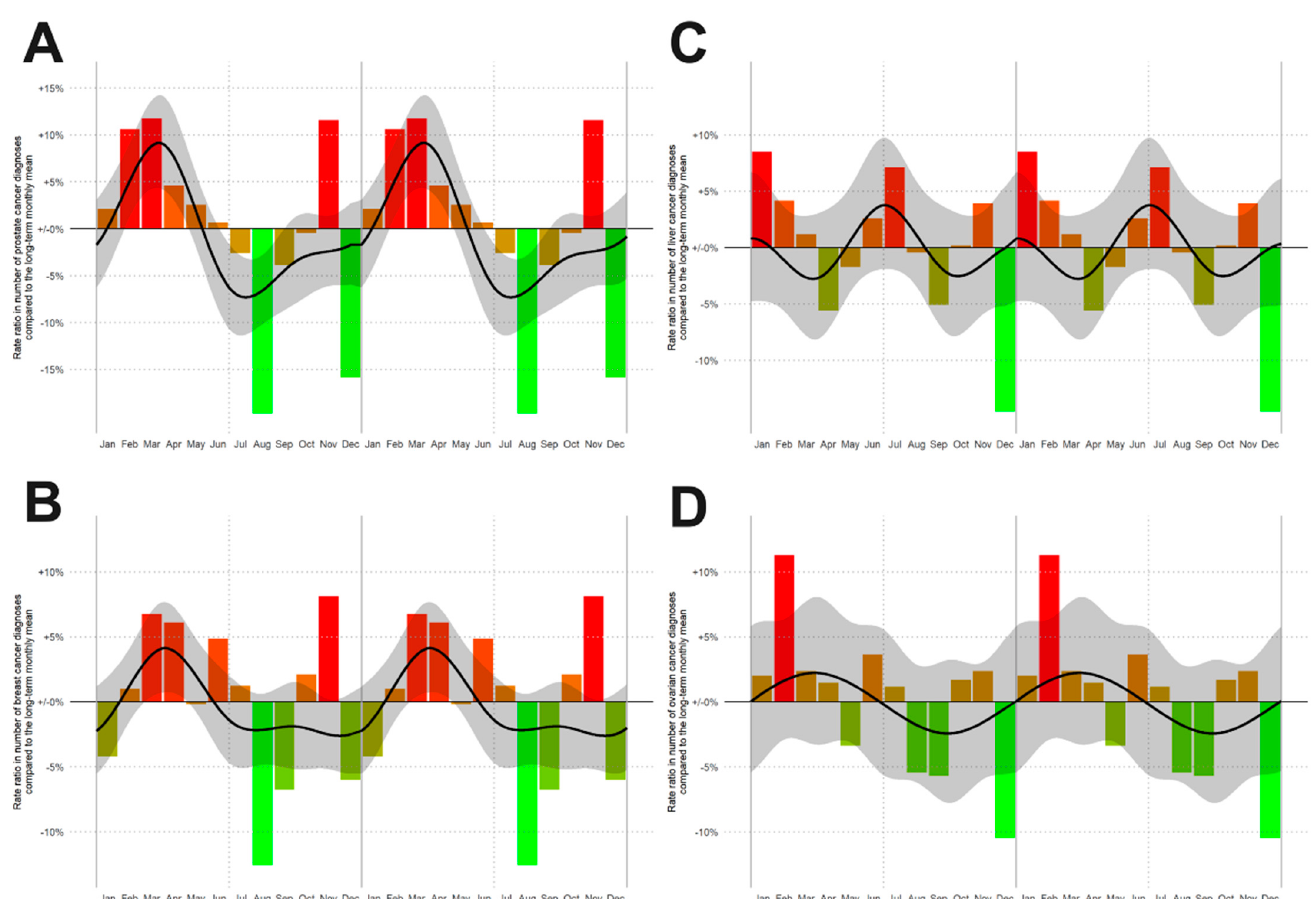
Figure 2. Rate ratios (RRs) of the number of new cancer diagnoses by month of diagnosis for: ( A ) prostate cancer, ( B ) breast cancer, ( C ) liver tumor and ( D ) ovarian carcinoma. From red to green in descending order of RRs. The smoothed RR curve, modelled via natural cubic splines, is overlaid in black together with 95% confidence bands (shaded).